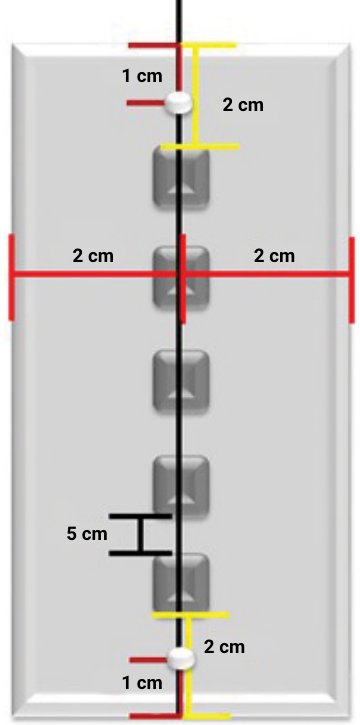
Figure. 1 - Schematic drawing of the acrylic plate (8.5 cm long, 4 cm wide and 0.5 cm thick). Metal brackets were positioned 0.5 mm distant from each other. The archwire was fixed on the brackets to frictional force